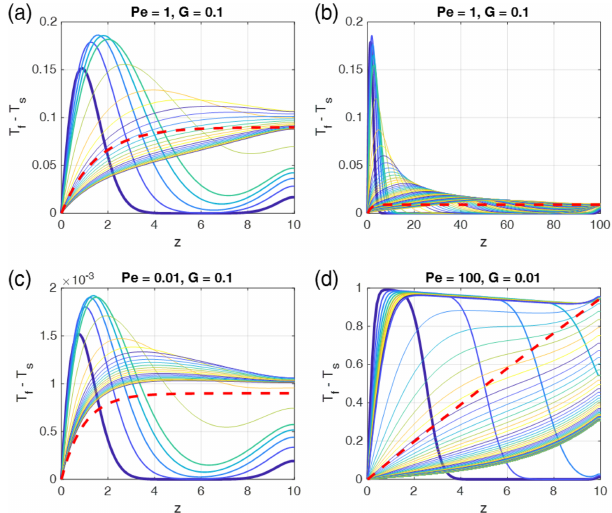
Figure 7. Time- and depth-dependent numerical solutions (thin curves) as in Fig. 5 but for step-function initial conditions: T f = T s = 1 at z = 0 and T f = T s = 0 at z > 0 at t = 0. The bold dashed red curves are the time-independent analytical solutions as in Fig. 5. In each panel the curves show (T f − T s ) profiles for progressive times, and the colors are cyclically varied with time from blue to yellow, starting with blue (bold curve). In each panel the first five curves (and later curves, respectively) are plotted at time incre- ments of (a) 0.5 (5), (b) 1 (10), (c) 0.5 (5), and (d) 0.025 (1). The to- tal non-dimensional times of each panel are 100 (500 for G = 0 . 01). Steady state is reached in the models with G = 0 . 1. The model with G = 0 . 01 would need t = 10000 to reach steady state. As porosity φ = 0 . 1 is